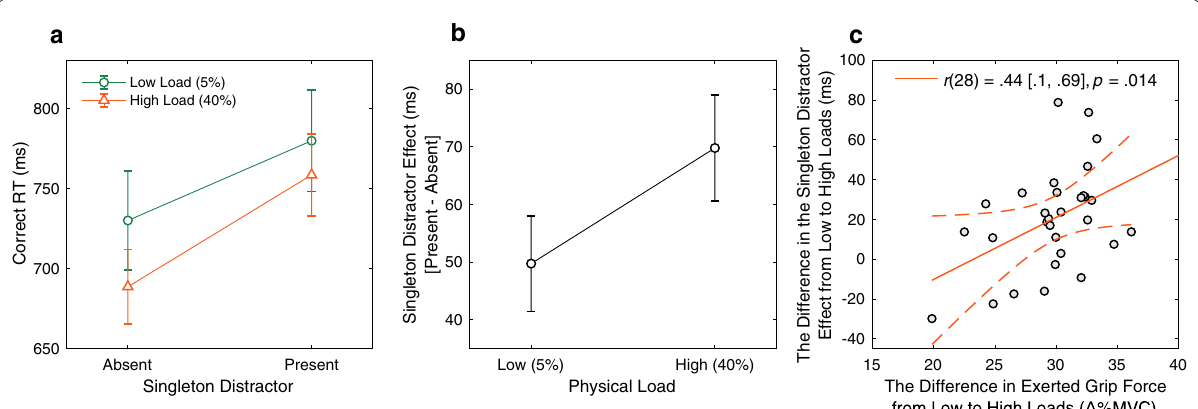
Fig. 2 RT results. a Mean RTs from trials with correct responses for both tasks across the singleton distractor present and singleton distractor absent conditions, plotted separately for low physical versus high physical load conditions. b Singleton distractor effects were assessed as the difference in RTs between singleton distractor present and absent conditions. The high physical load condition resulted in a larger distractor interference effect. c The difference in the singleton distractor effect from low to high loads (i.e., the interaction effect in a ; see main text for detail) significantly correlated with the difference in exerted grip force from low to high loads (Δ %MVC : high–low load) across the participants. The solid and dashed lines represent the best linear fit and its 95% confidence interval, respectively. Pearson correlation coefficient ( r ) with 95% confidence interval and p value are presented in the figure. Error bars in a and b represent standard error of